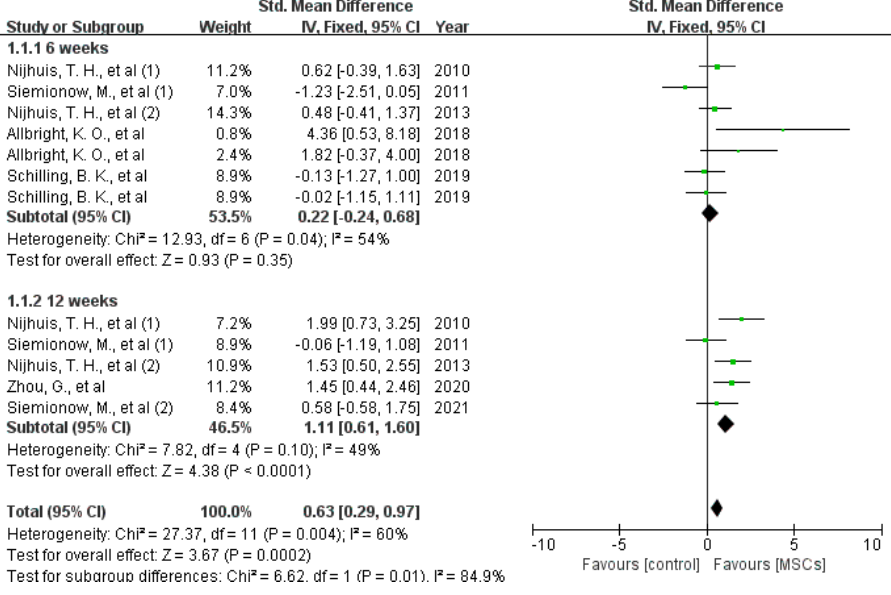
Figure 6. Meta ‐ analysis of the weight of gastrocnemius muscles 6 weeks and 12 weeks after surgery Figure 6. Meta-analysis of the weight of gastrocnemius muscles 6 weeks and 12 weeks after [5,11–36]. Plots on the right ‐ hand side indicate favoring MSCs or MSCs ‐ loaded scaffolds, while plots surgery [5,11–36]. Plots on the right-hand side indicate favoring MSCs or MSCs-loaded scaffolds, on the left side indicate favoring placebo ‐ control treatment or blank scaffolds. while plots on the left side indicate favoring placebo-control treatment or blank scaffolds.